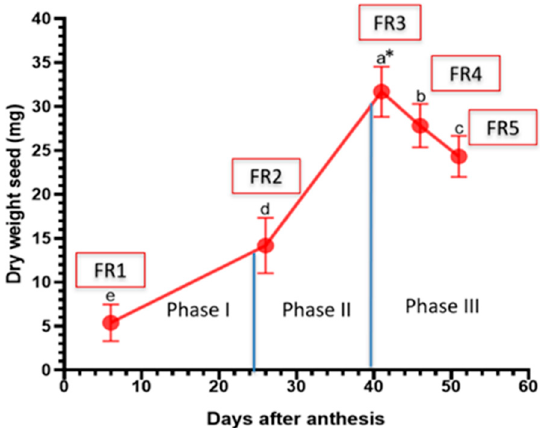
Figure 5. Dry weight of A. pelegrina seeds at different maturity stages. FR1: Fruit stage 1; FR2: Fruit stage 2; FR3: Fruit stage 3; FR4: Fruit stage 4; FR5: Fruit stage 5. * Values with different letters in the graph indicate statistically significant differences, Tukey ( p ≤ 0.05). The bars represent the standard error.